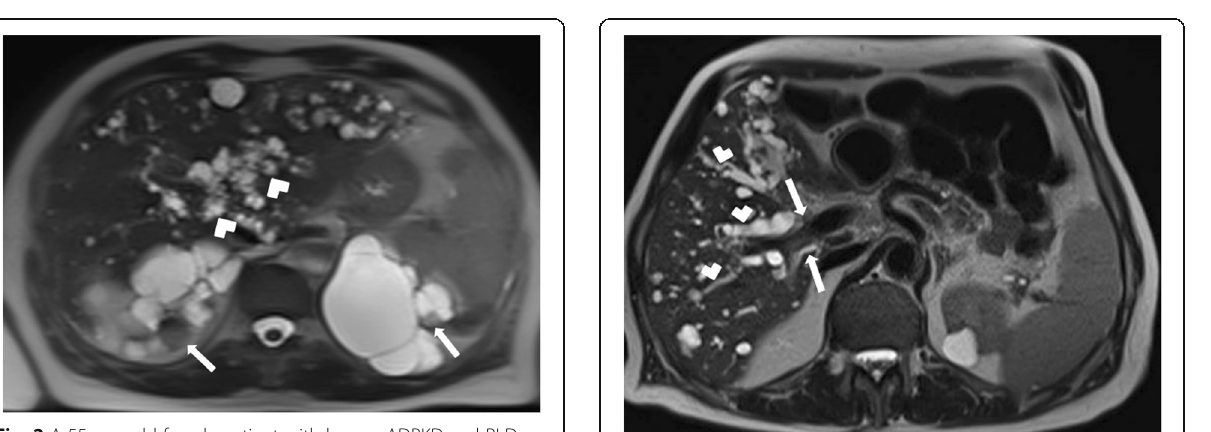
Fig. 2 A 55-year-old female patient with known ADPKD and PLD. Axial plane T2W fat-saturated MR image shows multiple bilateral renal cysts with hemorrhagic cysts (arrows) and peribiliary cysts (arrowheads) in the liver